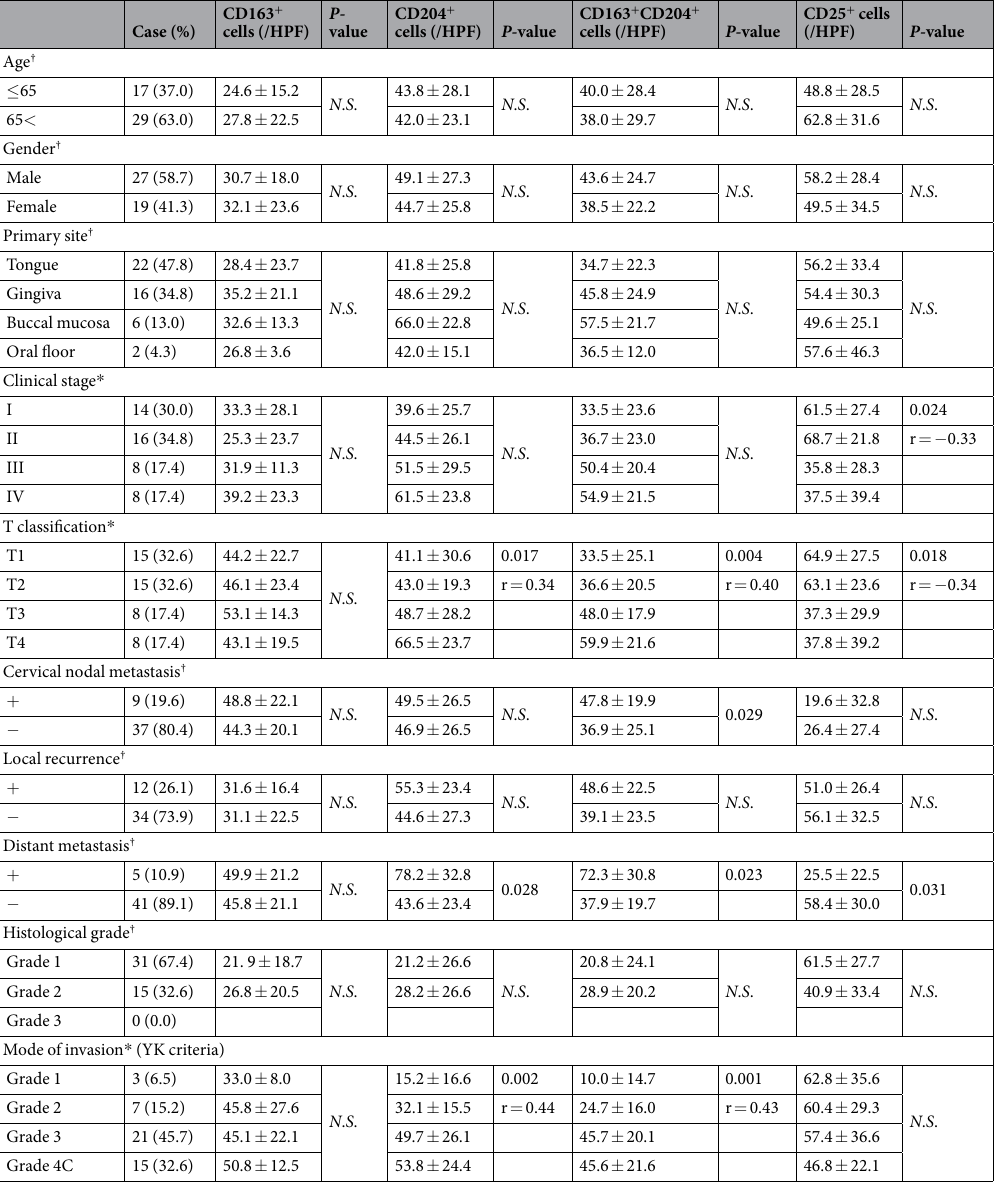
Table 1. Association of tumor-associated macrophages (TAMs) with clinicopathologic characteristics in OSCC. * Spearman’s rank correlation coefficient, † Mann-Whitney U -test and Wilcoxon signed-rank test. Not significant: N . S